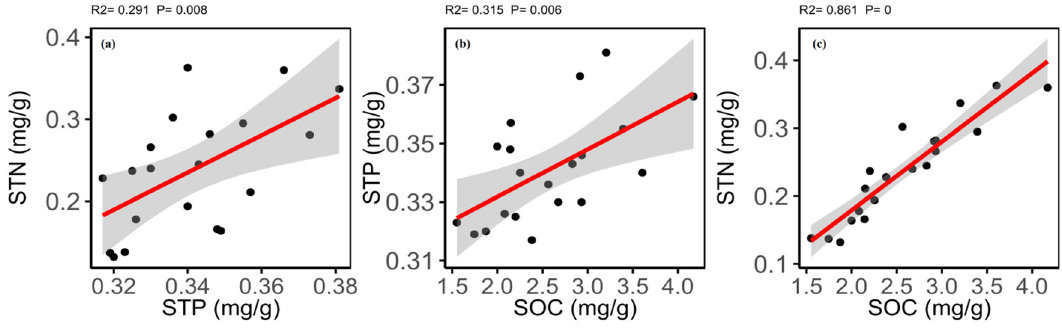
Figure 6. Relationship between ( a ) soil total phosphorus (STP) and soil total nitrogen (STN); ( b ) soil organic carbon (SOC) and soil total phosphorus (STP); and ( c ) soil organic carbon (SOC) and soil total nitrogen (STN).